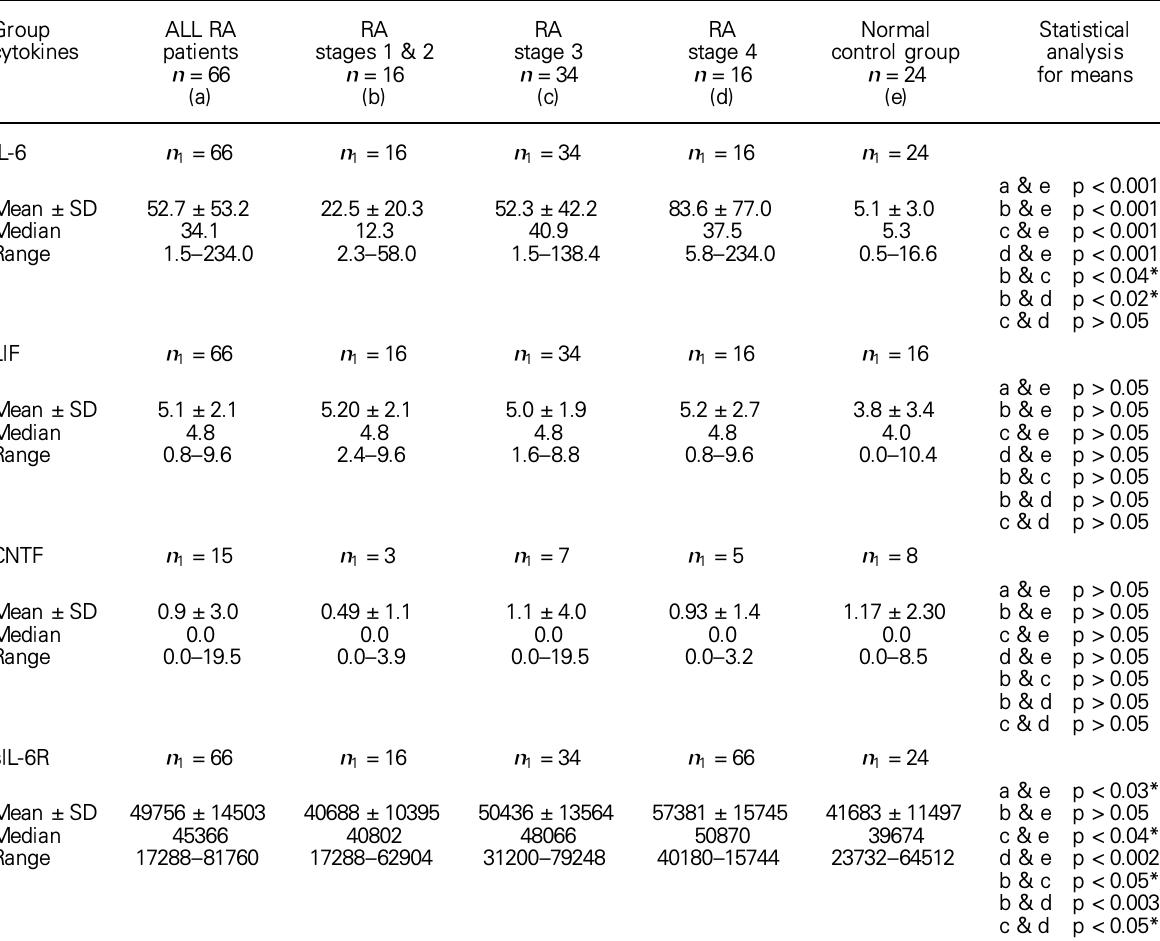
Table 2. Serum levels of IL-6, LIF, CNTF and sIL-6R in patients with RA according to disease activity (according to Mallya and Mace) and normal control group. Mean values in pg/ml ± SD, median and range in parentheses Group ALL RA cytokines